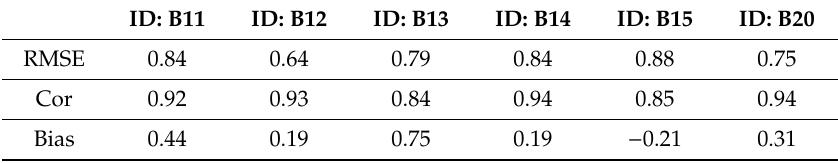
Table 3. Comparison between the results from the SWAN model and the moored